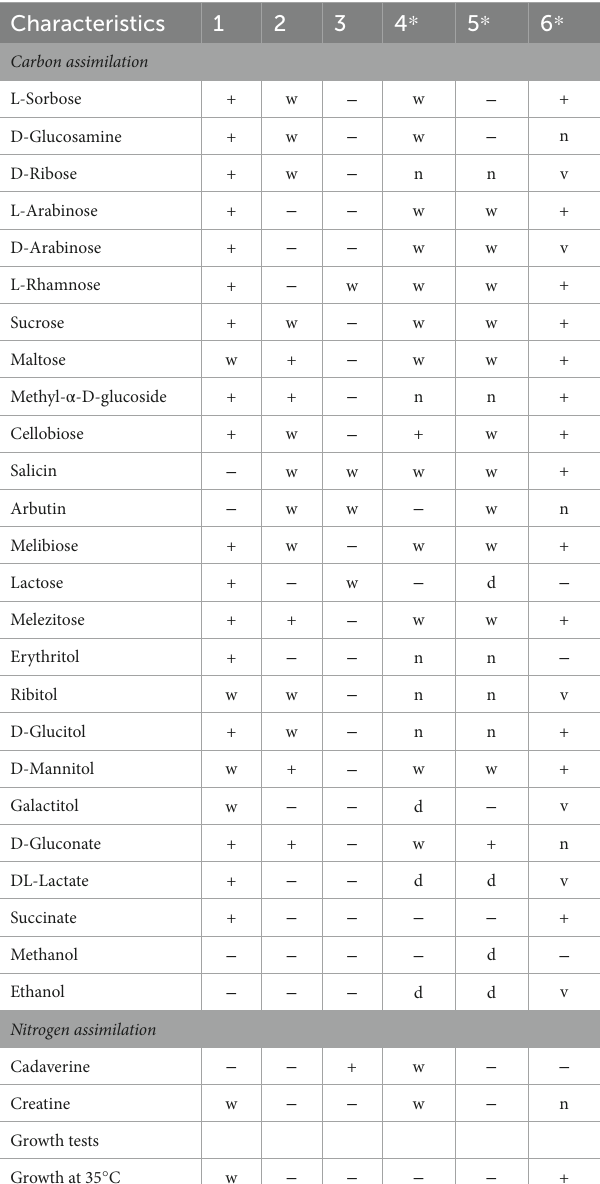
TABLE 3 Phenotypic characteristics that differed between the three novel species and their most closely related